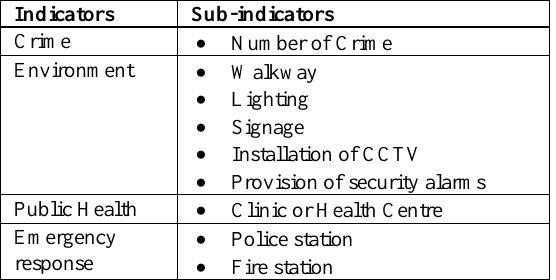
Table 4. Indicators and sub-indicators to assess safety level, via integrating spatial